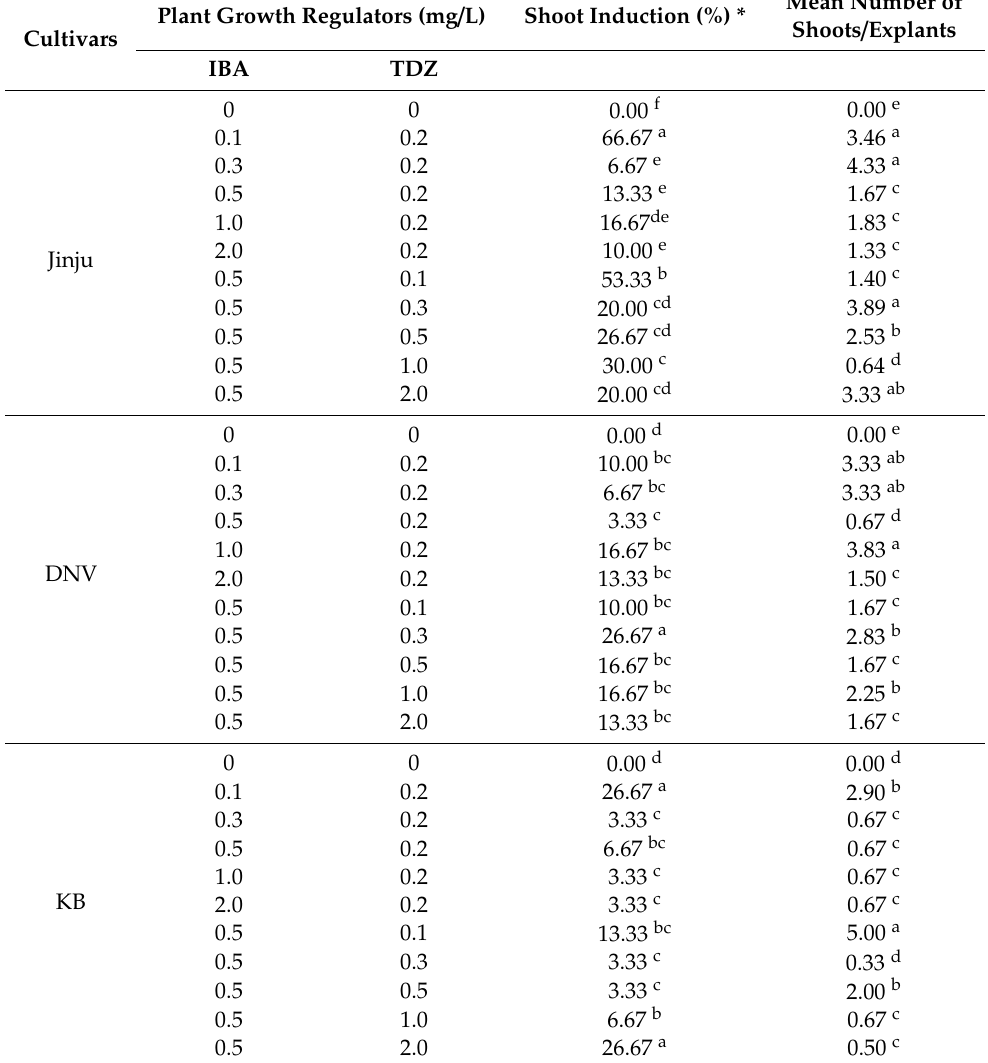
Table 1. E ff ect of di ff erent concentrations of plant growth regulators (PGR) combinations on shoot induction from Type 3 medium-derived vitrified leaf